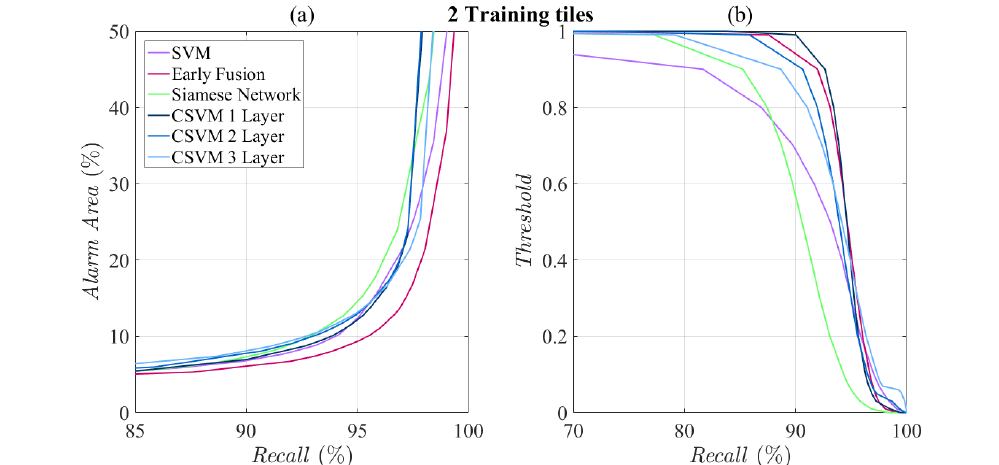
Figure 22. ( a ) Recall vs. Alarm Area (deforested area) for Cerrado biome using two training tiles. ( b ) The recall values are obtained by threshold variation.